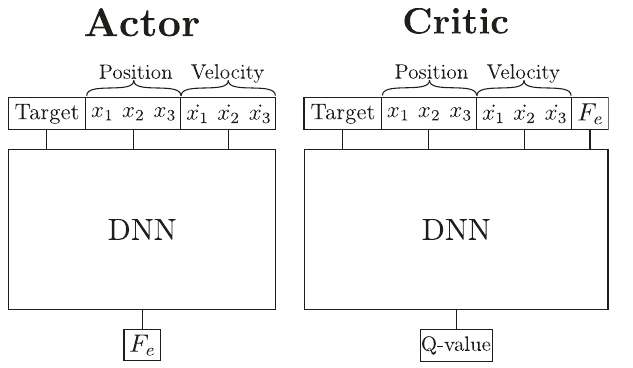
Fig. 6 Architecture of the actor and critic. The schematics details the input and the output associated with the actor and the critic. “ Target" corresponds to the target con fi guration (001 for instance) and “ DNN" corresponds to the neural networks detailed in Table 2. Table 2 Policy (Actor) and Q-function (Critic) models.